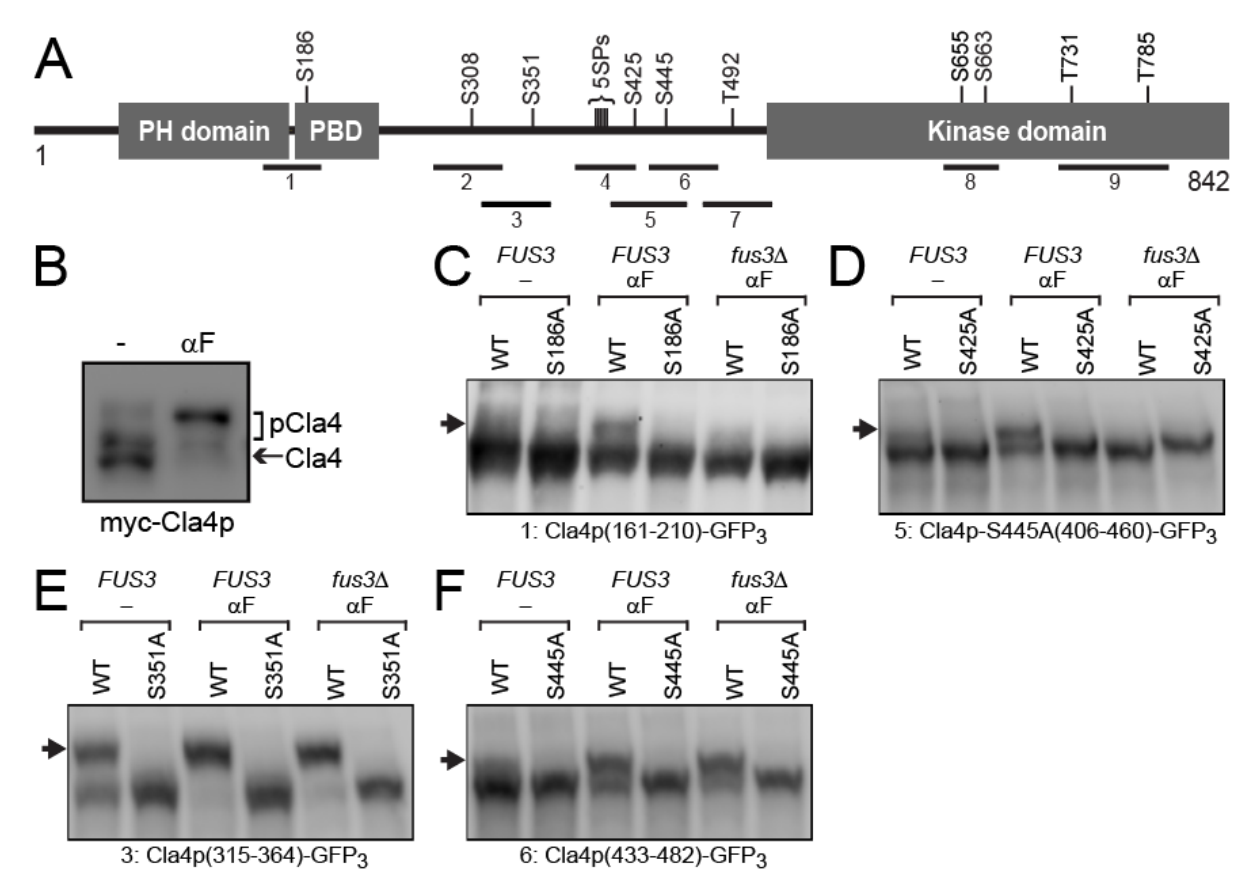
Figure 2. Screening for mating ‐ specific and Fus3p ‐ dependent phosphorylation sites in Cla4p. ( A ) Schematic representation of Cla4p. The PH (Pleckstrin Homology, 64–175 aa), PBD (p21 ‐ Rho ‐ binding domain, 184–242 aa), and Kinase domain (517–842 aa) are indicated. The Cla4p fragments examined in this study and the positions of the 15 proline ‐ directed serines (SP) or threonines (TP) are indicated. ( B ) Hyper ‐ phosphorylation of Cla4p during mating. The myc ‐ Cla4p was expressed in a cla4 Δ strain (MY13001) for 2 h, plus or minus pheromone, electrophoresed on a 50 μ M Phos ‐ tag gel, and detected with anti ‐ myc. The bracket marked “pCla4” indicates phosphorylated species. ( C – F ) The indicated truncations of Cla4p, fused to GFP 3 were expressed in FUS3 (MY11198) or fus3 Δ cln3 Δ 2 h. Samples were run on 50 μ M Phos ‐ tag gels and detected by anti ‐ GFP. Arrowheads indicate phos ‐ phorylated species. ( C – F ) Indicated truncations on plasmids were expressed. ( C ) pMR6414 and